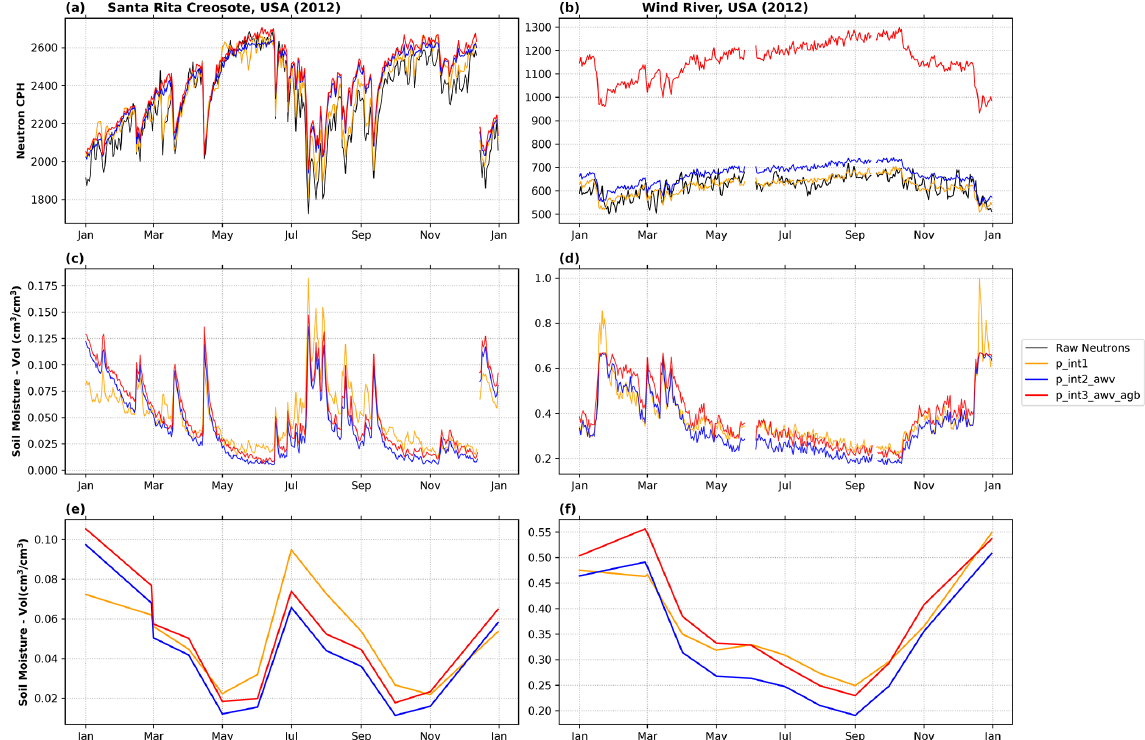
Figure 3. Example of CRNS data obtained at two distinct sites: Santa Rita Creosote (a, c, e) and Wind River (b, d, f) . Daily neutron counting rates (raw and corrected based on the different strategies outlined in Table 1) are shown in panels (a) and (b) . Derived soil moisture estimates (cm 3 cm − 3 ) are shown at daily and monthly timescales in panels (c) and (d) and in panels (e) and (f)